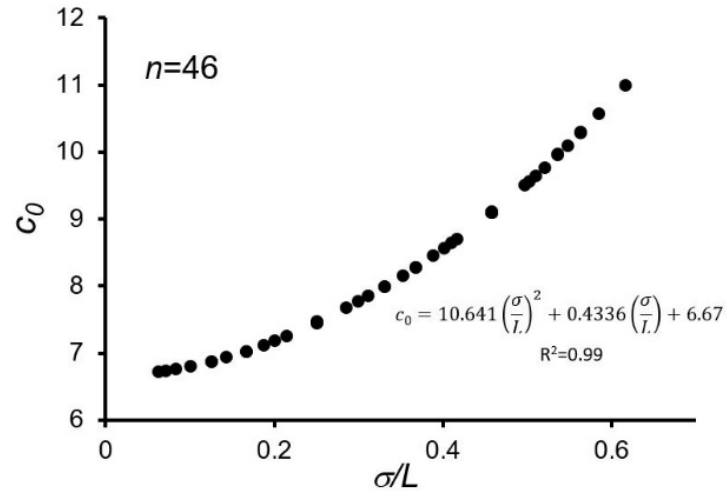
Figure 14. Relation between c 0 (i.e., C-factor when d = 0) and σ / L .